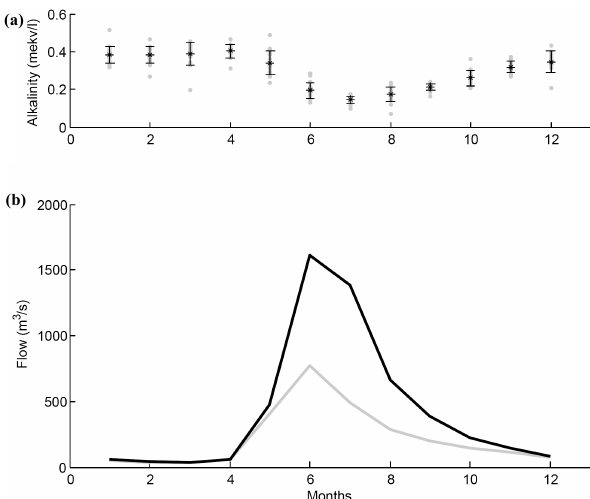
Fig. 2. (a) Long-term (22 years) observations of monthly alkalinity concentrations (grey dots) at the outlet of the Abiskojokken catch- ment and (b) the resultant hydrograph separation between shallow (area between black and grey lines) and deep (area below the grey line) ground water. In (a), crosses show the mean in a given month and vertical bars show one standard deviation. In (b), uncertainty bounds are not shown as this estimate is intended to give a first- order approximation of the partitioning of flow between the shallow and deeper